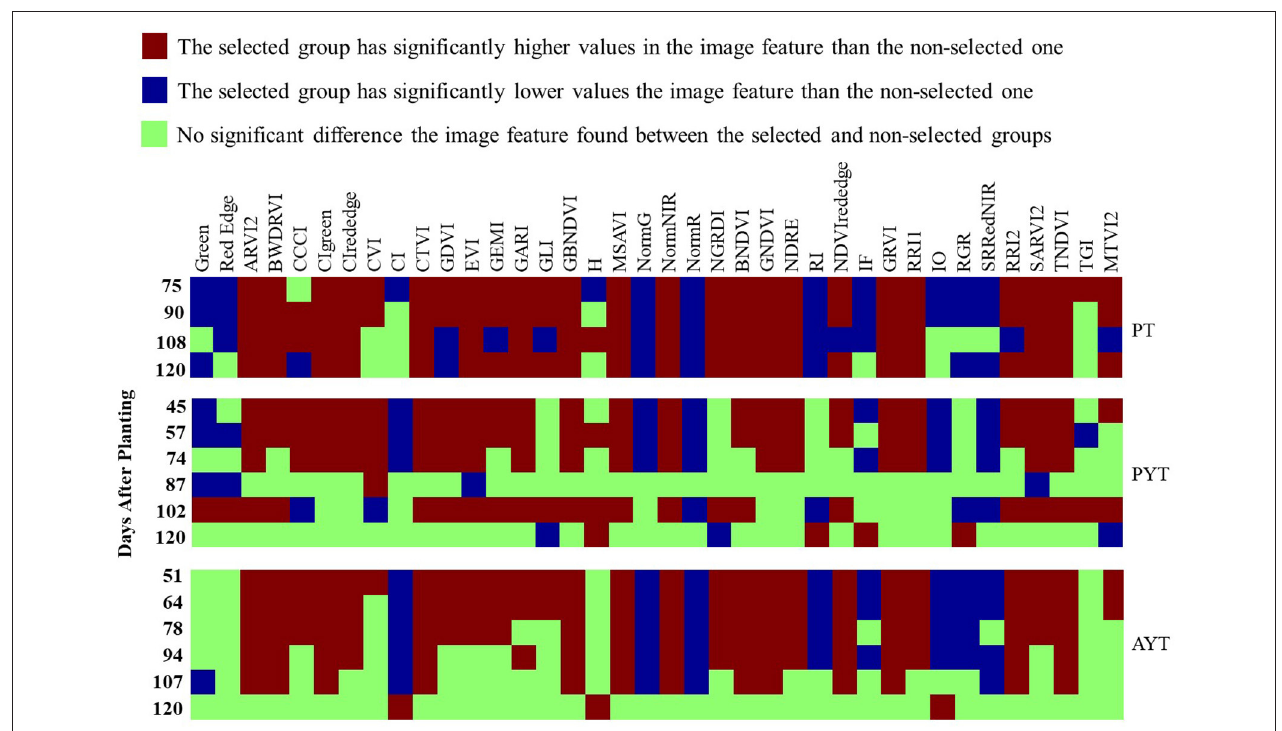
FIGURE 8 | The significance map of the differences in image features between the selected and non-selected groups. Each square represents if there is a significant difference in an image feature collected at single times ( p < 0.05) between the two groups.